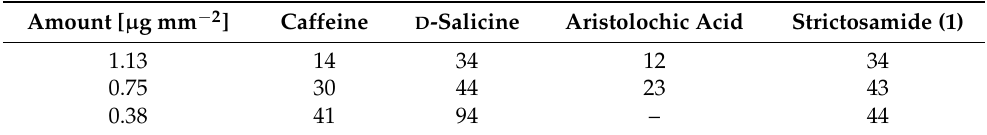
Table 1. Percentages of consumed leaf mass in gustatory experiments with Spodoptera littoralis . The values calculated are related to the